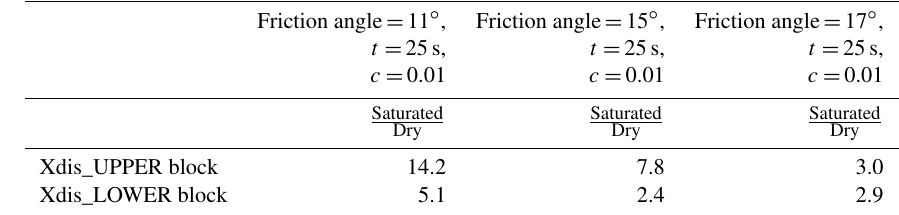
Table 7. The role of water in the model behaviour. Values are based on recorded displacements under scenarios 9, 10, 11, 14, 16 and 17.